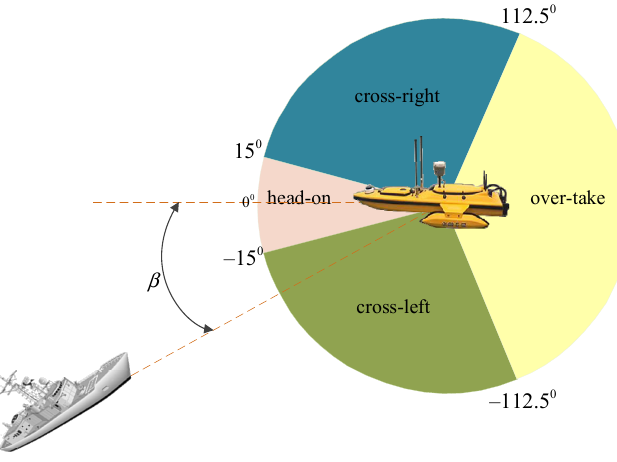
Figure 5. Definition of multi-vessel encounters scenario.